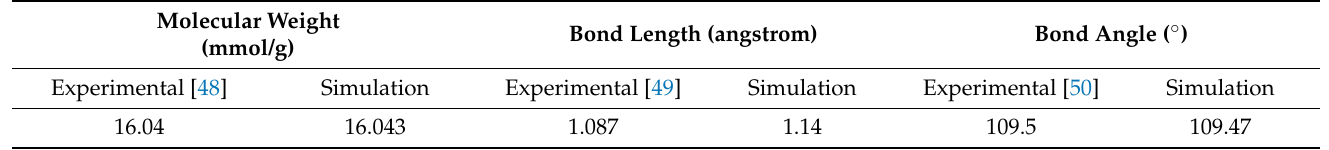
Table 1. Comparison between methane simulated and experimental properties.